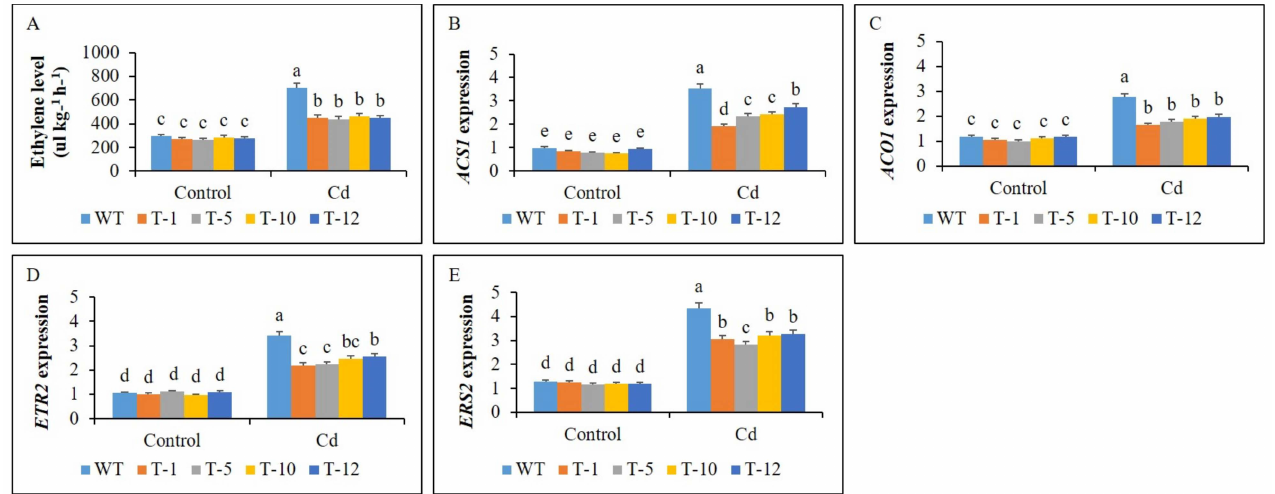
Figure 6. Comparison of ethylene production ( A ) and transcript levels of genes associated with ethylene biosynthesis and signaling ( B – E ) in the leaves of WT and transgenic petunia cv. ‘Mirage Rose’ plants under control and cadmium (Cd) stress conditions. Data were collected on the 30th day of the experiment. Data represent the means of three replicates and error bars indicate standard error. Means with the same letters are not significantly different by least significant difference test (LSDT, p <